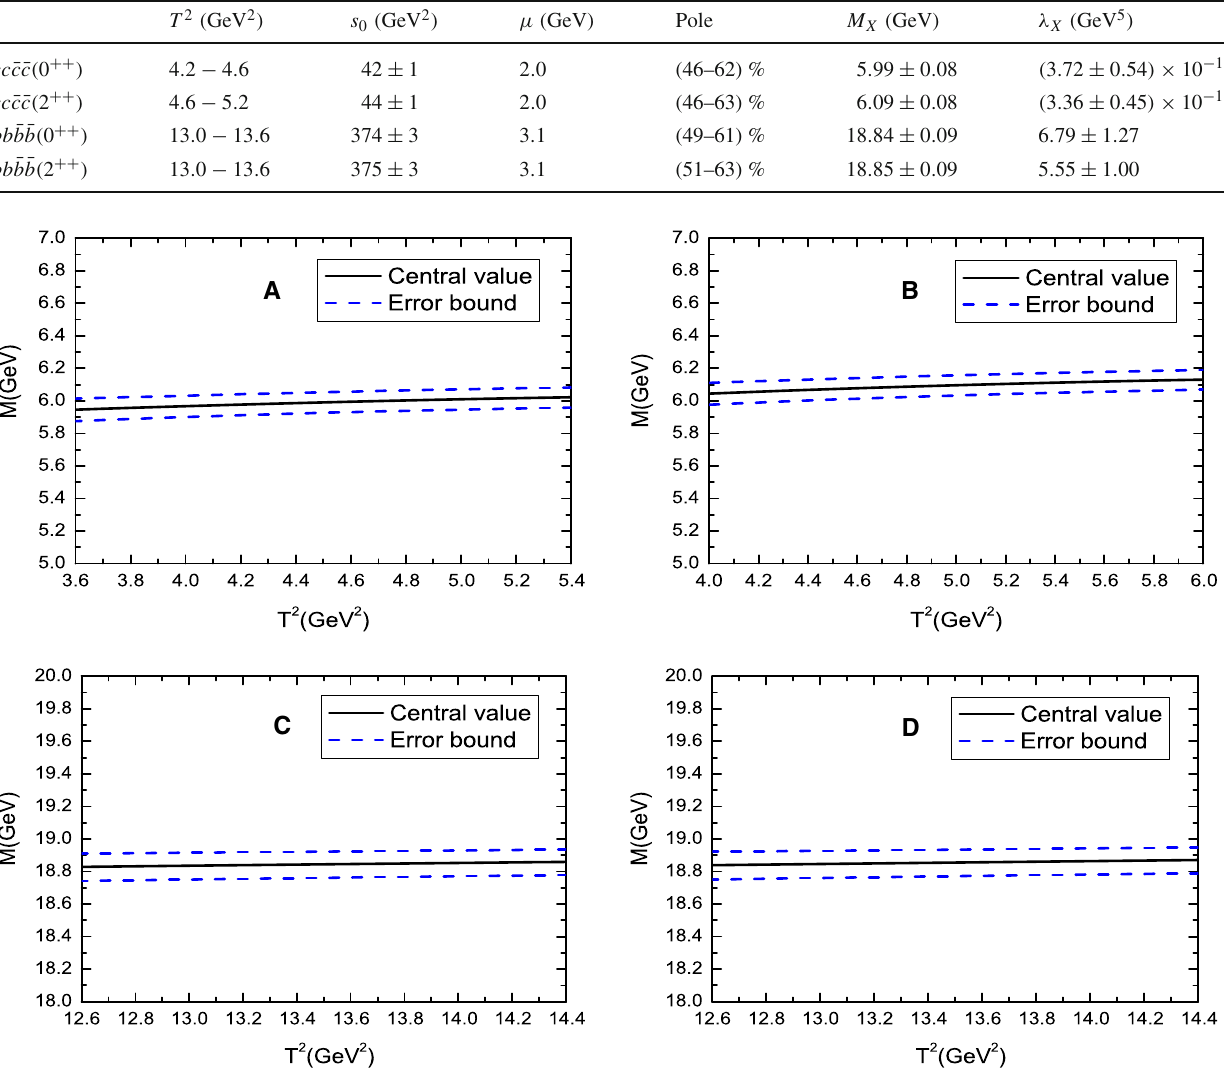
Fig. 3 The masses of the tetraquark states with variations of the Borel parameters T 2 , where A , B , C and D denote cc ¯ c ¯ c ( 0 ++ ) , cc ¯ c ¯ c ( 2 ++ )